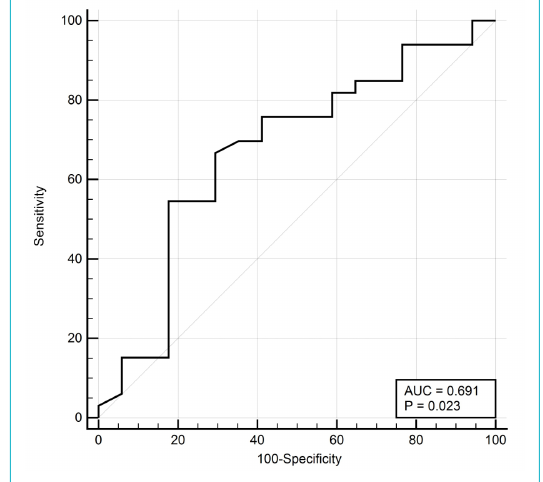
Figure 3: Diagnostic value of fecal calprotectin to identify small bowel findings in patients with suspected Inflammatory bowel dis- ease. Receiver operating characteristics (ROC) with area under the curve (AUC).